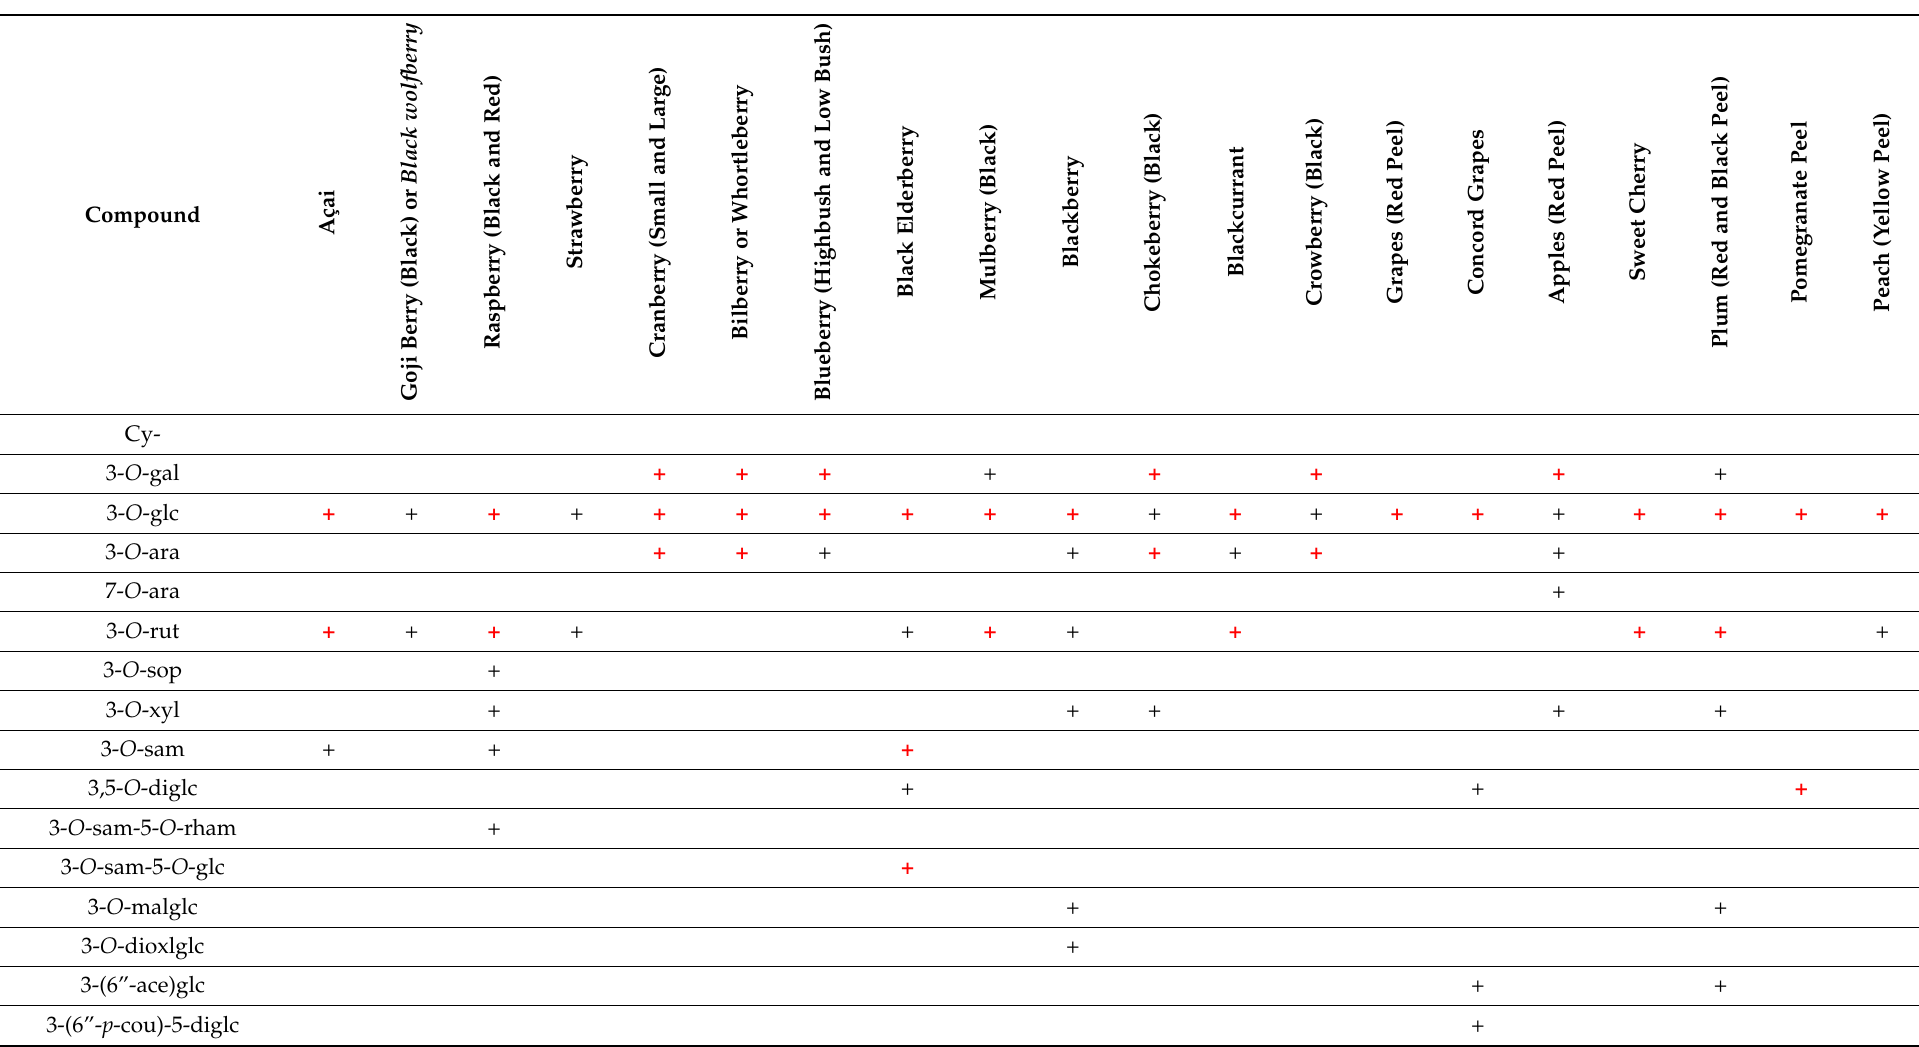
Table 2. Occurrence of anthocyanins in different berry and fruit varieties based on NMR and LC methods.